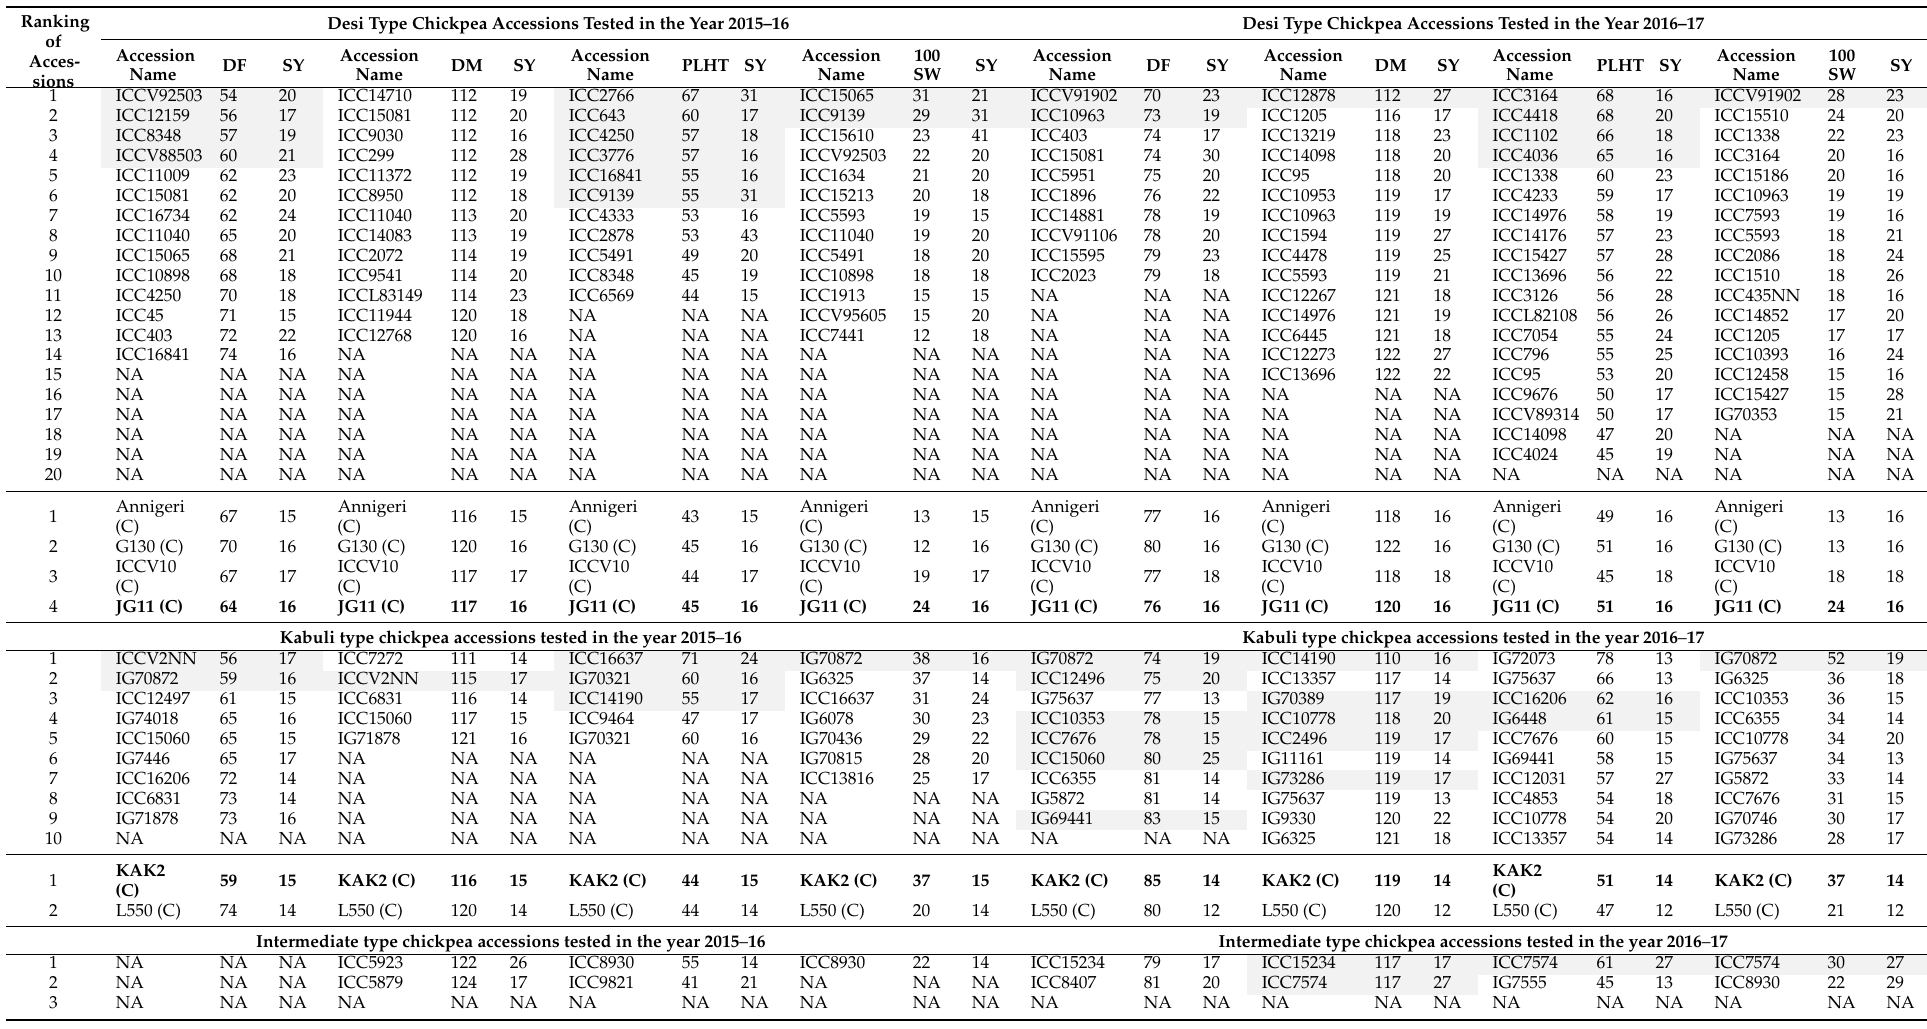
Table 5. Shortlisted germplasm accessions based on ranking biplot for five traits across two years for Kanpur, Uttar